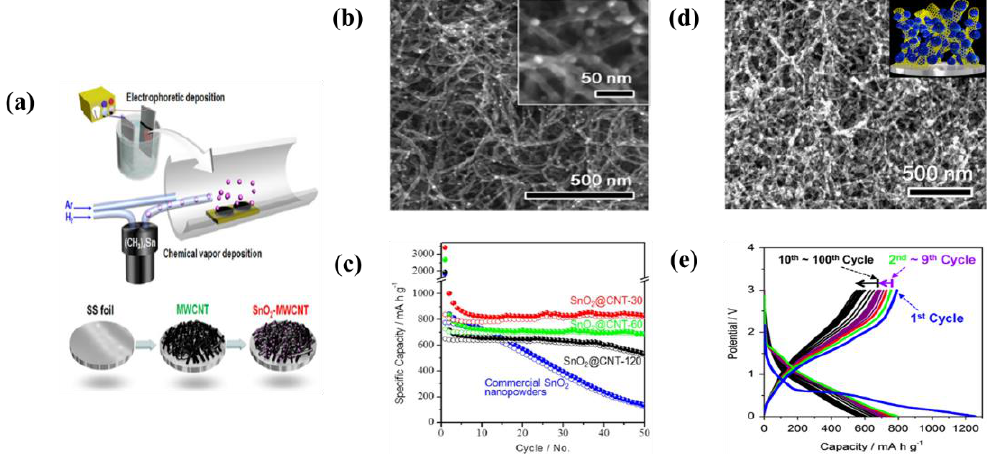
Figure 13. ( a ) Schematic illustration of the two-step process for the SnO 2 -CNT electrode; ( b ) SEM image of binder-free SnO 2 nanoparticles-CNT electrode; ( c ) Cycling performance of binder-free SnO 2 nanoparticle-CNT electrode; ( d ) SEM image of binder-free CoO nanoparticle-CNT electrode. ( e ) Charge-discharge curves of CoO nanoparticle-CNT electrode.